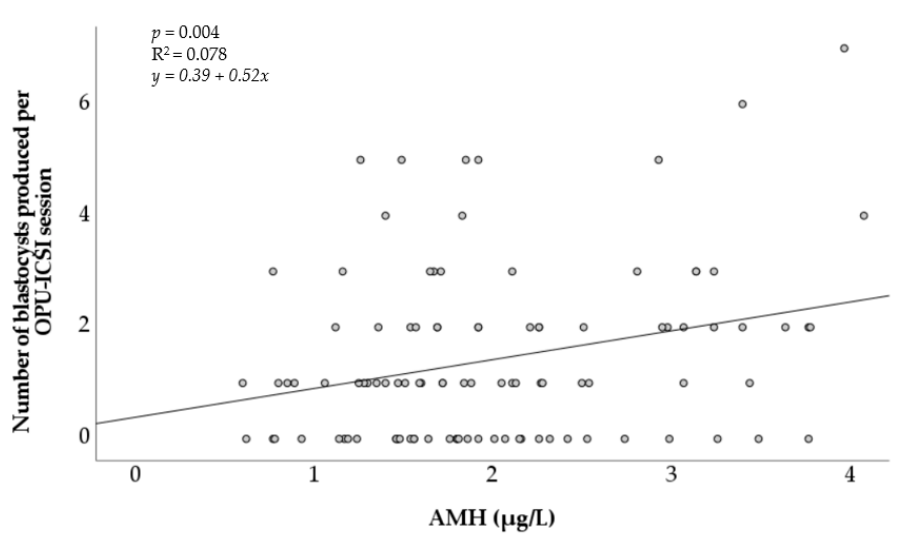
Figure 2. Association of the number of in vitro blastocysts produced after OPU-ICSI with the concentration of circulating anti-Müllerian hormone in individual mares. AMH = anti-Müllerian hormone. R 2 = coefficient of determination. Table 1. Effect of serum AMH concentration on the OPU-ICSI outcome in mares.